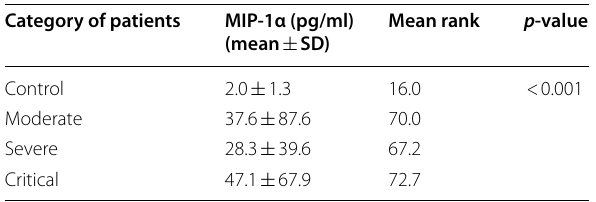
Table 3 Association of serum level of MIP-1α (pg/ml) among different categories of COVID-19 patients and healthy controls